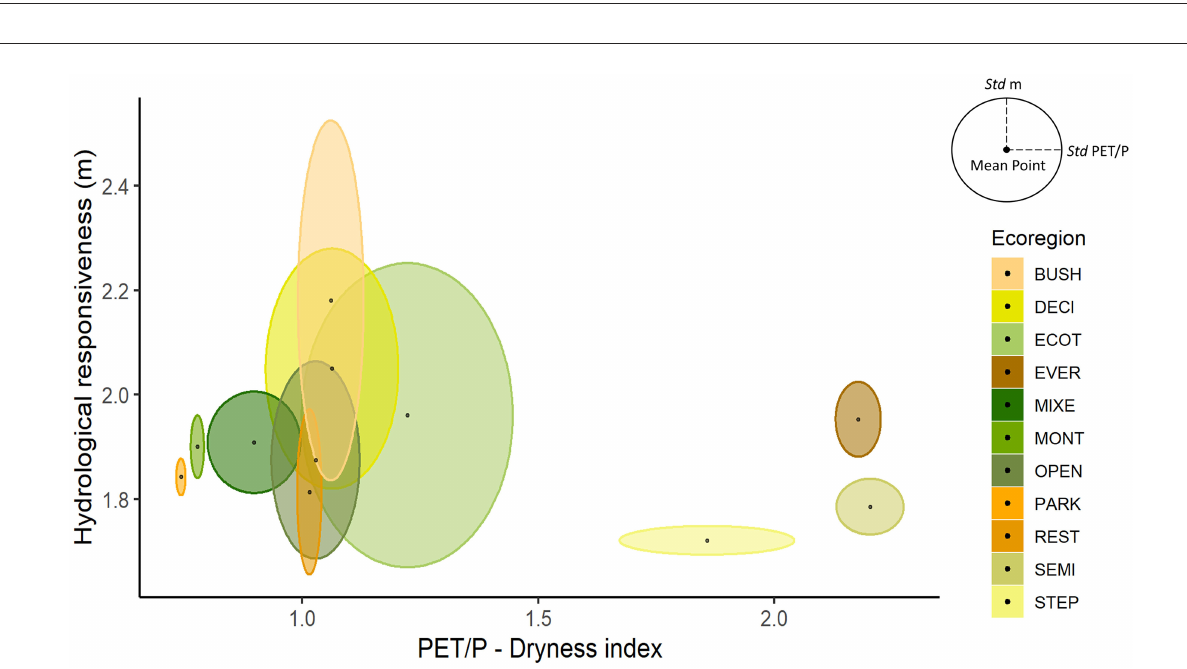
FIGURE6 Variation in the mean values of hydrological responsiveness (m) and dryness index (PET/P) in each of the Atlantic Forest ecoregions, Brazil. Ellipses are formed by the standard deviation of the mean. REST, Arboreal restinga and mangrove; BUSH, Bushy grassland; DECI, Deciduous broadleaved forest; ECOT, Ecotone; EVER, Evergreen broadleaved forest; MIXE, Mixed needle-broadleaved forest; MONT, Montane and upper montane forest; OPEN, Open ombrophilous forest; PARK, Parkland savanna; SEMI, Semideciduous broadleaved forest; STEP, Steppe savanna.